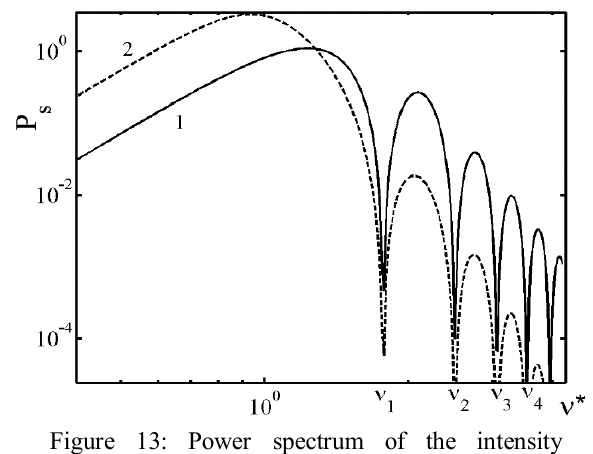
Figure 11. Normalized scintillation level versus parameter ¡ for different parameter c